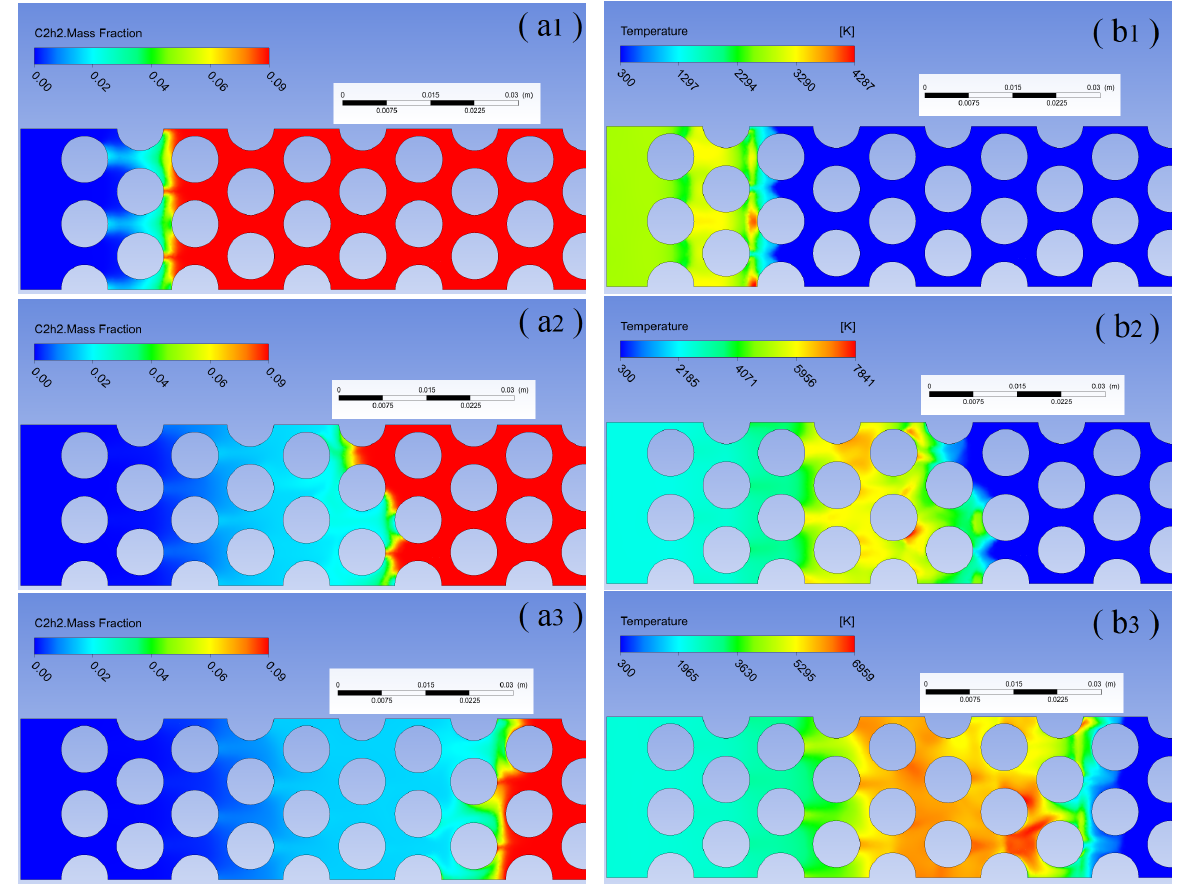
Figure 6. Simulated profiles of mass fraction of acetylene and temperature in the center-plane between the side walls at times: t 1 = 1.81 × 10 − 5 s, t 2 = 5.18 × 10 − 5 s, and t 3 = 7.70 × 10 − 5 s corresponding to the three rows: ( a1 – a3 )—mass fraction of C 2 H 2 ; ( b1 – b3